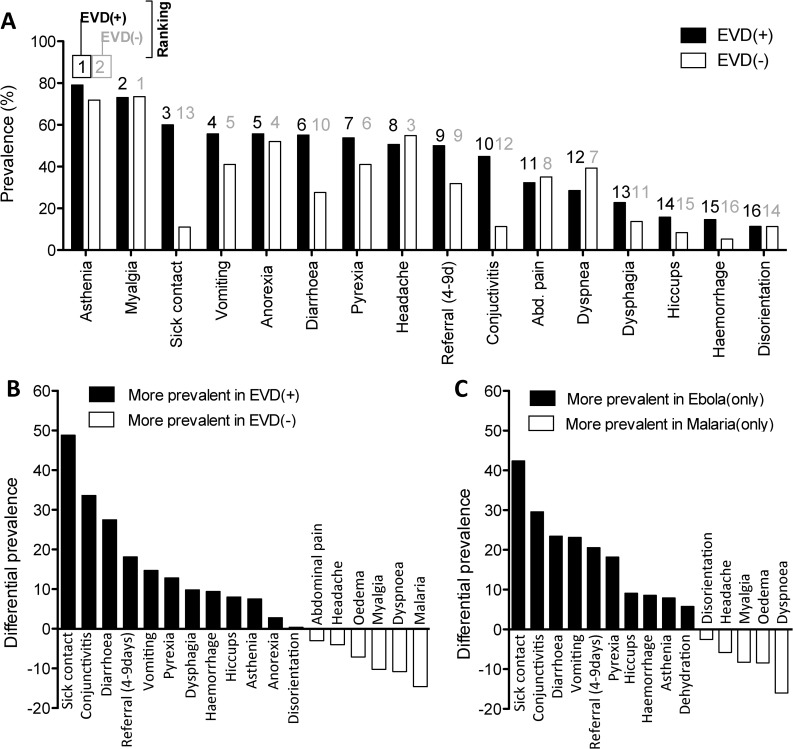
Prevalence of the clinical signs and symptoms recorded at triage.(A) Prevalence of triage symptoms for EVD(+) and EVD(-) cohorts ranked according to the prevalence in EVD(+). Rankings from 1–16 are listed above each bar: black for EVD(+) and grey for EVD(-). (B) Differences in symptom prevalence between EVD(+) and EVD(-) cohorts. Positive values are more prevalent in EVD(+) cases. Negative values are more prevalent in EVD(-) cases. (C) Differences in symptom prevalence between EVD(+)only patients and malaria(+)only patients. Positive values are more prevalent in EVD(+)only cases. Negative values are more prevalent in malaria(+)only cases. EVD(+)only: EVD(+)/malaria(-); Malaria(+)only: EVD(-)/malaria(+)